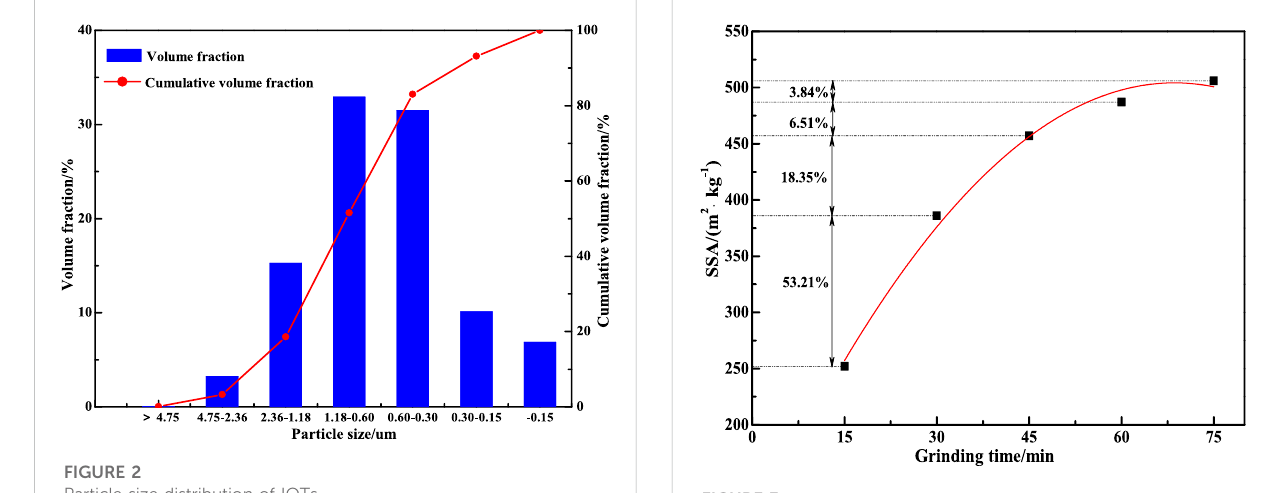
FIGURE 2 Particle size distribution of IOTs. FIGURE 3